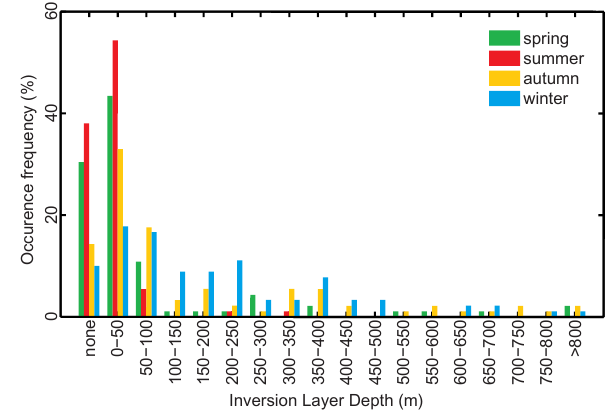
Figure 4. The occurrence frequency of different temperature